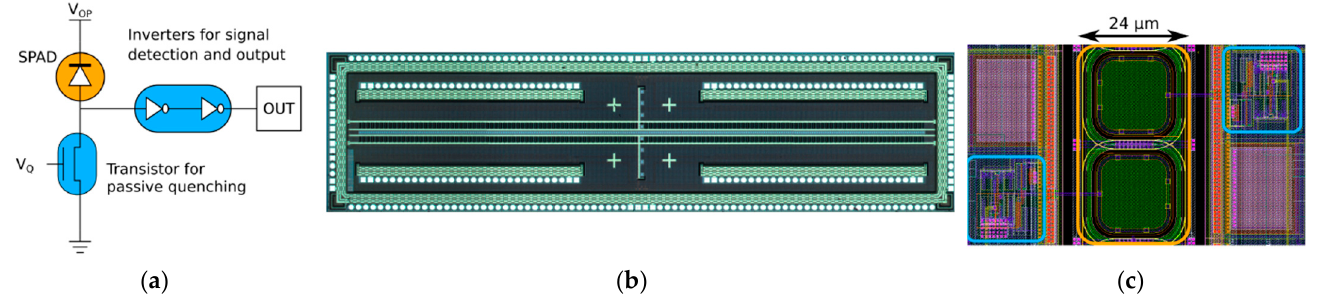
Figure 11. ( a ) Single-pixel schematics, ( b ) micrograph of LinoSPAD, and ( c ) two pixels layout [72].